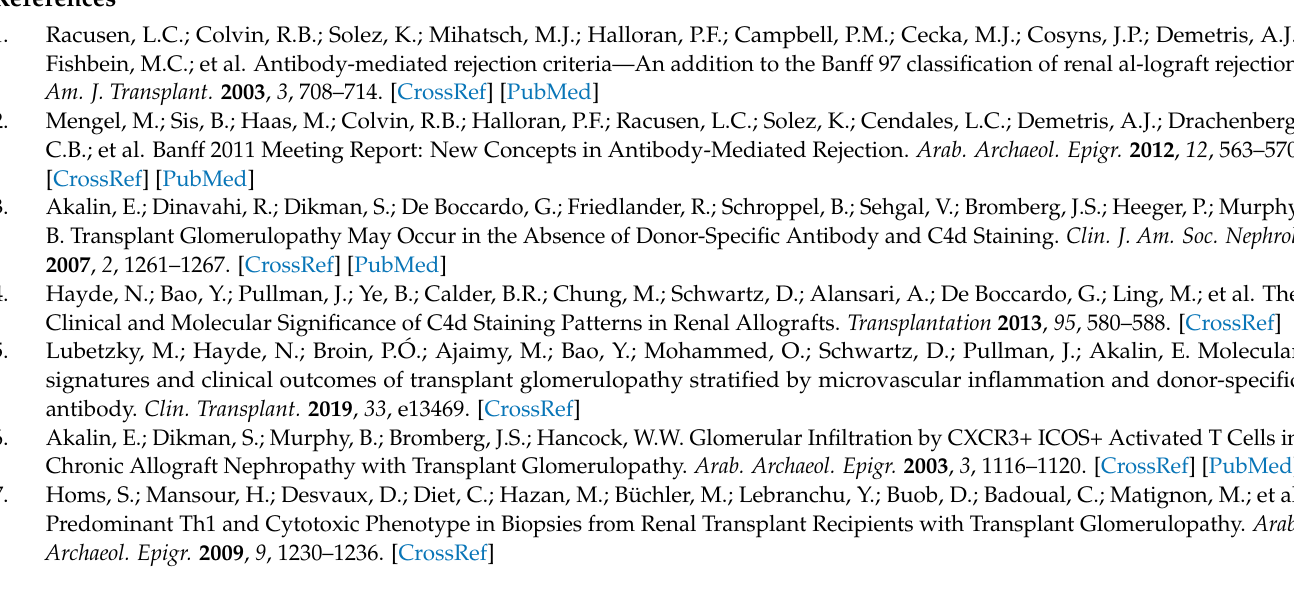
RNA sequencing, Table S2: Differentially expressed tRNA fragments in TG compared to normal allograft function, Table S3: Differentially expressed miRNAs in TG compared to normal allograft function, Table S4: Differentially expressed miRNAs in TG compared to normal allograft function. Table S5: Differentially expressed genes in TG compared to normal allograft